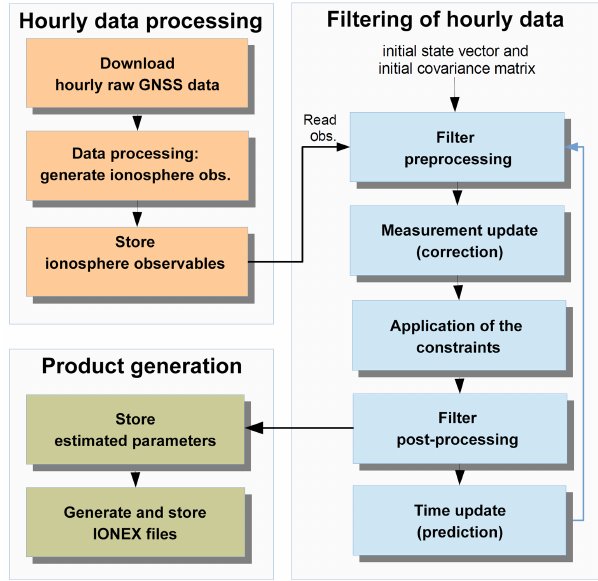
Figure 3. Overall scheme for the global VTEC estimation and the product